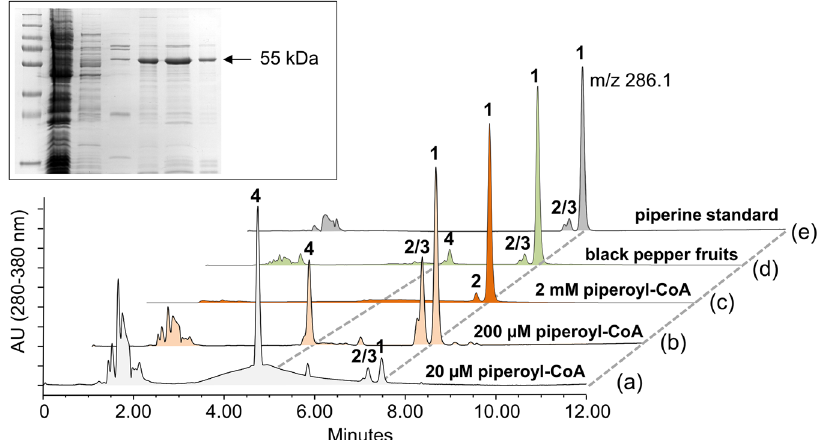
Fig. 4 Enzyme activity of recombinant and native piperine synthase. Representative chromatograms (detection by UV/Vis) displaying the formation of piperine (1) at different substrate concentrations of piperoyl-CoA with piperine synthase ( a – c ), partly puri fi ed native piperine synthase activity ( d ), piperine standard ( e ), (2/3), isopiperine and chavicine, (4), piperic acid. SDS-PAGE of recombinant piperine synthase puri fi cation is shown as an insert. The position of the 55 kDa signal representing recombinant piperine synthase during puri fi cation is marked with an